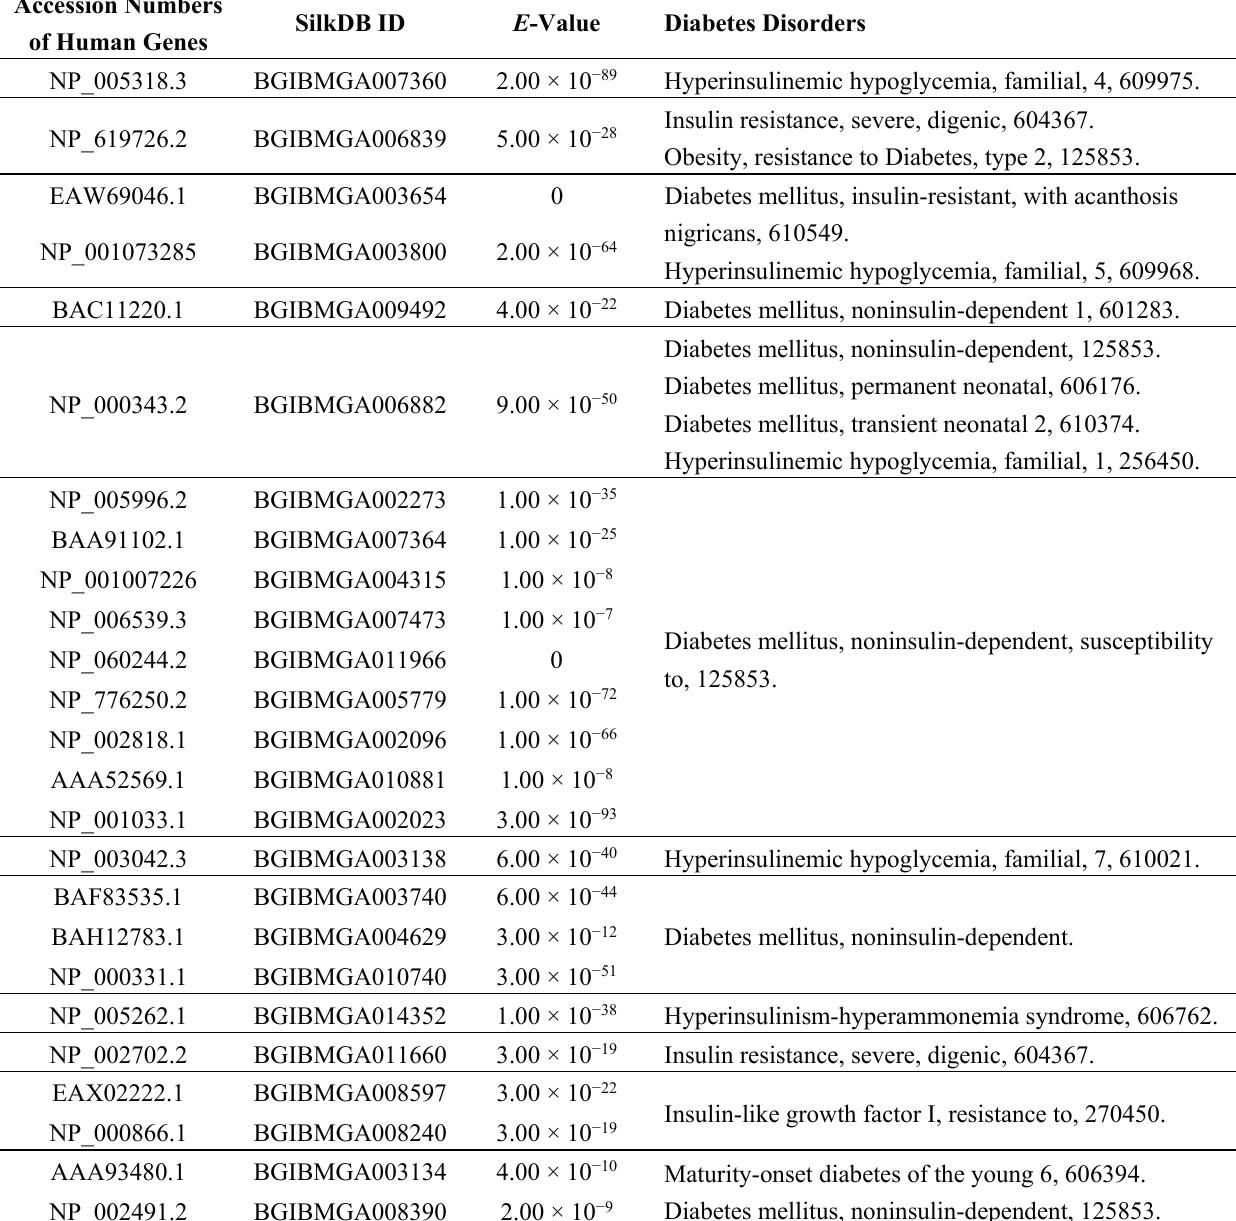
Table 1. The silkworm orthologs of human genes associated with diabetes